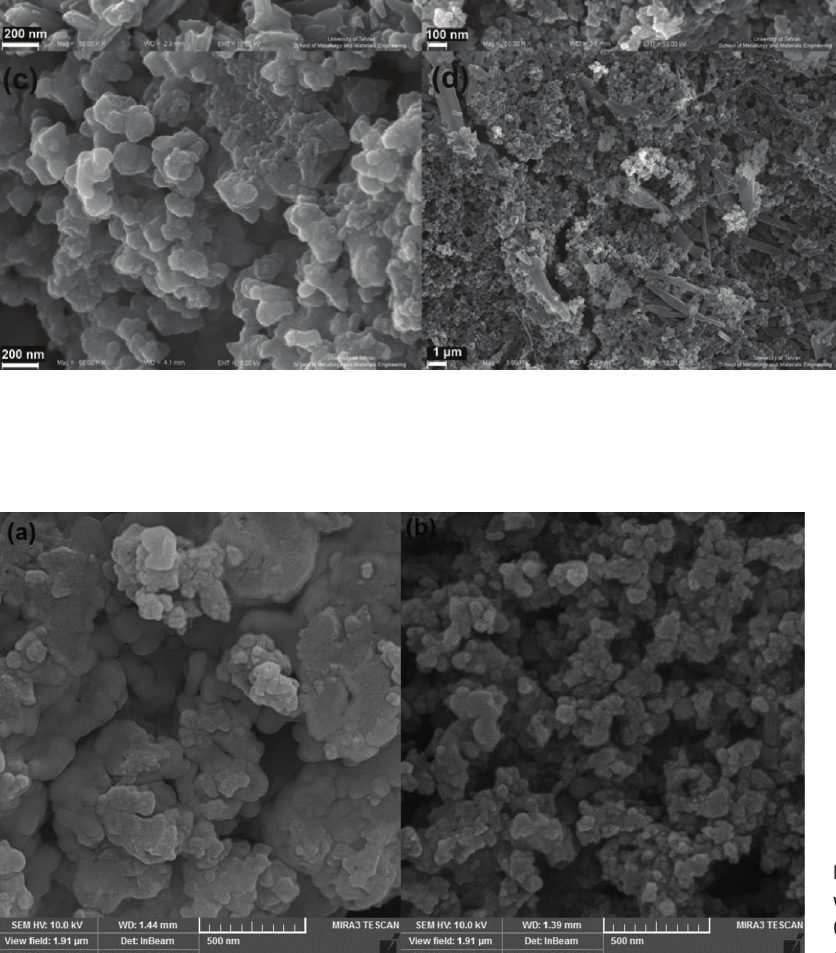
Figure 5: SEM of posnjakite nanoparticles without surfactant: (a) 1:1 and (b) 1:4 (CuSO 4 : thio-Schiff base molar ratio) in 600 W and 15